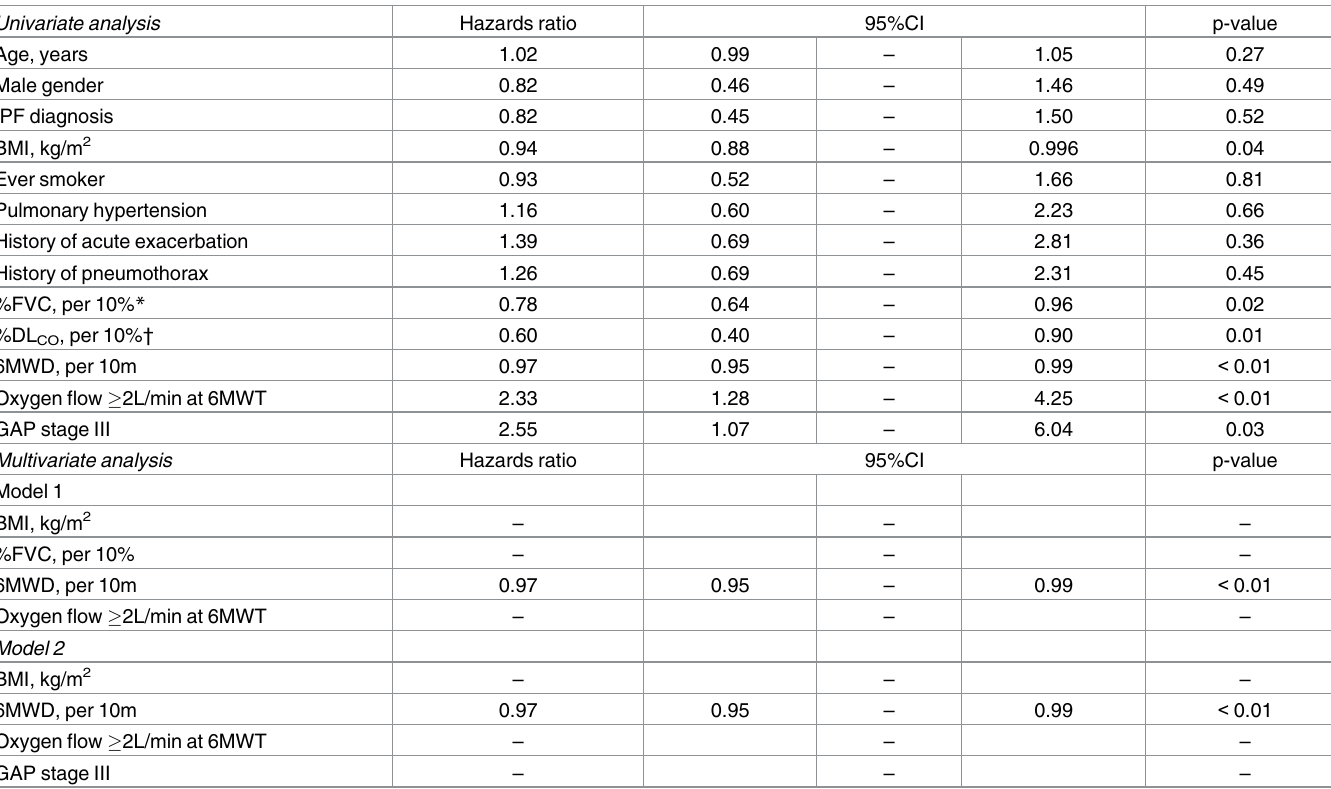
Table 3. Cox proportional hazards model results for evaluating the risk of mortality in lung transplant candidates with interstitial lung disease (n =